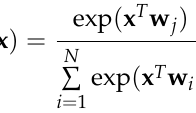
Figure 7. The proposed multi-class surface defect recognition model.